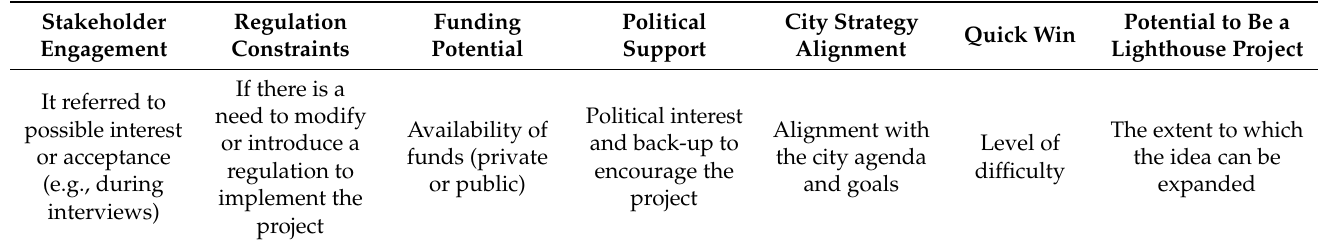
Table 3. Selection criteria for projects.